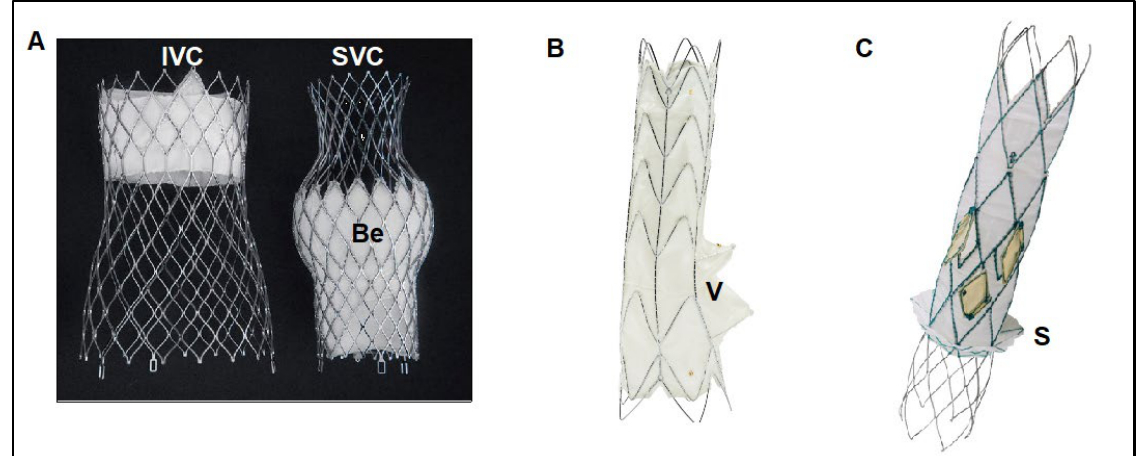
Figure 4. Current dedicated CAVI devices. ( A ) The TricValve ® device consists of 2 self-expanding nitinol valvular stent frame devices specifically designed for the cava, one for the SVC and another for the IVC. The SVC device has a belly portion (Be) with high radial force to fix and seal the device into the SVC, has a long skirt that covers the 1/2 inferior parts of the device for preventing para-valvular leak. The valve is placed in the inferior part of the device. The IVC device has a short skirt only covering the first 20 mm of the proximal edge for preventing hepatic vein occlusion, and high radial force at the valve level for fixing the device and preventing valve distortion or malfunction. ( B ) Tricento ® device is a customized device adapted to the anatomy of each particular patient. Device consists of a self-expanding covered stent frame placed into the SVC, right atrium and IVC with an opening valve (V) facing the tricuspid plane. ( C ) Trillium™ device is a cross-caval stent graft with multiple covered fenestrations arranged circumferentially around its right atrium portion. Trillium™ has a skirt at its inferior part to seal without occluding hepatic veins. Be: Belly part of TricValve ® superior prosthesis. IVC: Inferior Vena Cava. SVC: Superior vena cava. S: Skirt of Trillium™ system. V: Valve of Tricento ® system.